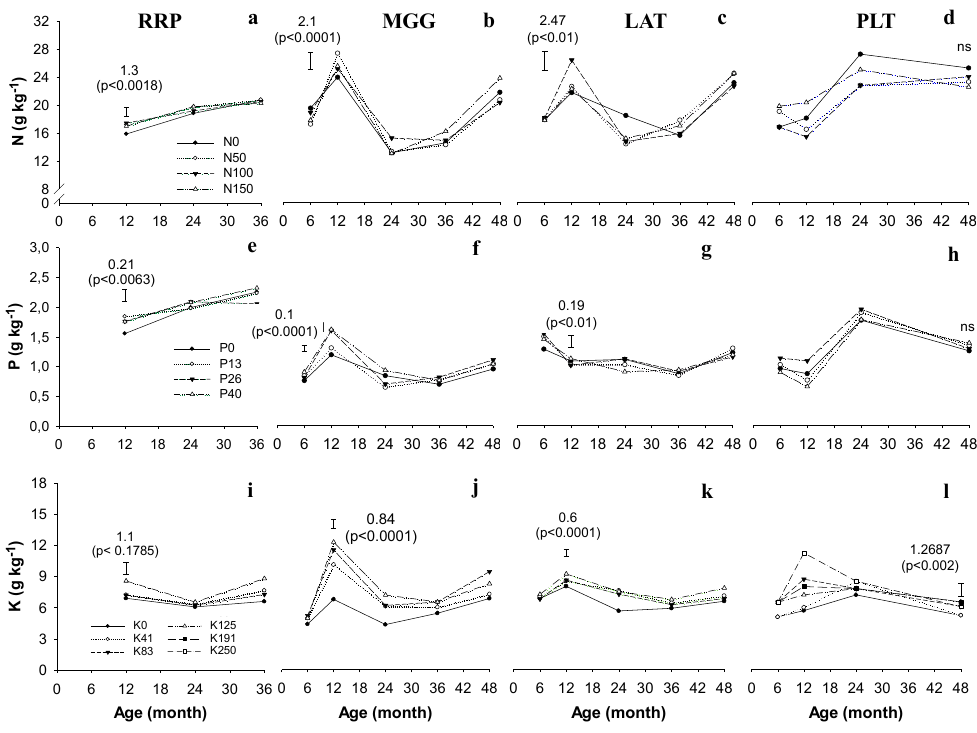
Figure 2. Nutrient leaf contents of N ( a – d ), P ( e – h ) and K( i – l ) for RRP ( a,e,i ), MGG ( b,f,j ), LAT ( c,g,k ) and PLT ( d,h,l ), according to the applied rates of the nutrients and stand age. Bars indicate the least significant difference by the LSD test ( p < 0.05).